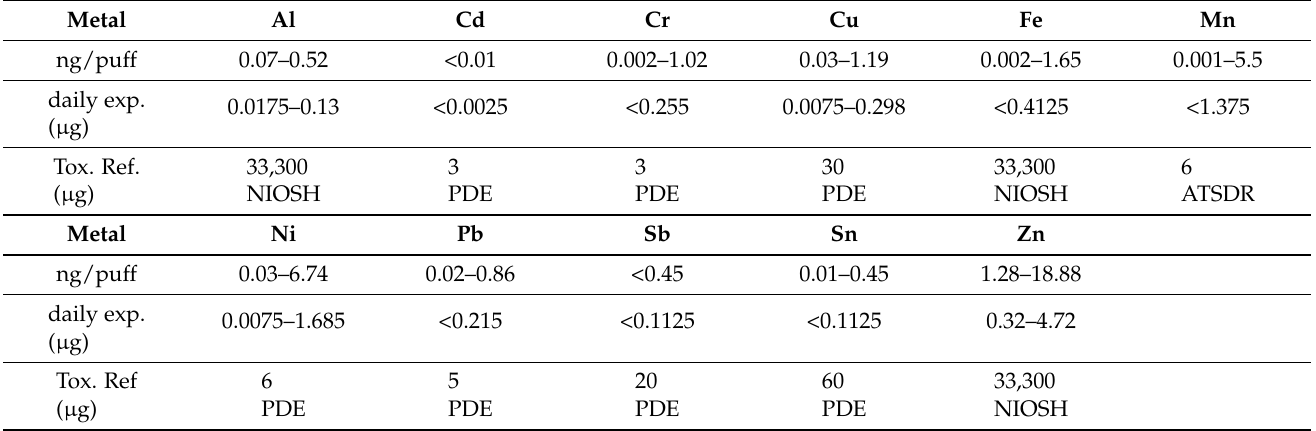
Table 4. First rows are outcomes of metal elements reported by Olmedo et al. [10] given as ng/puff values converted from their µg/kg concentrations (see supplementary file). The second rows are daily exposures form 250 daily puffs and third rows are toxicological reference markers from Table 2. Minimal values in the range of O ∼ 10 − 3 µg are not displayed.